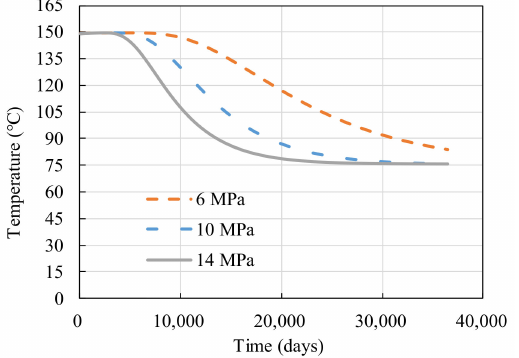
Figure 4. Effect of producing pressure differential on thermal